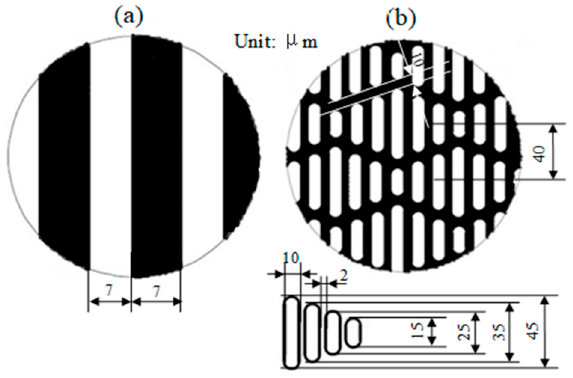
Figure 3. Photomask designs: ( a ) the micro-channel and ( b ) the sharklet patterns. Table 1. Geometrical measurements of depth and width of the silicon molds.